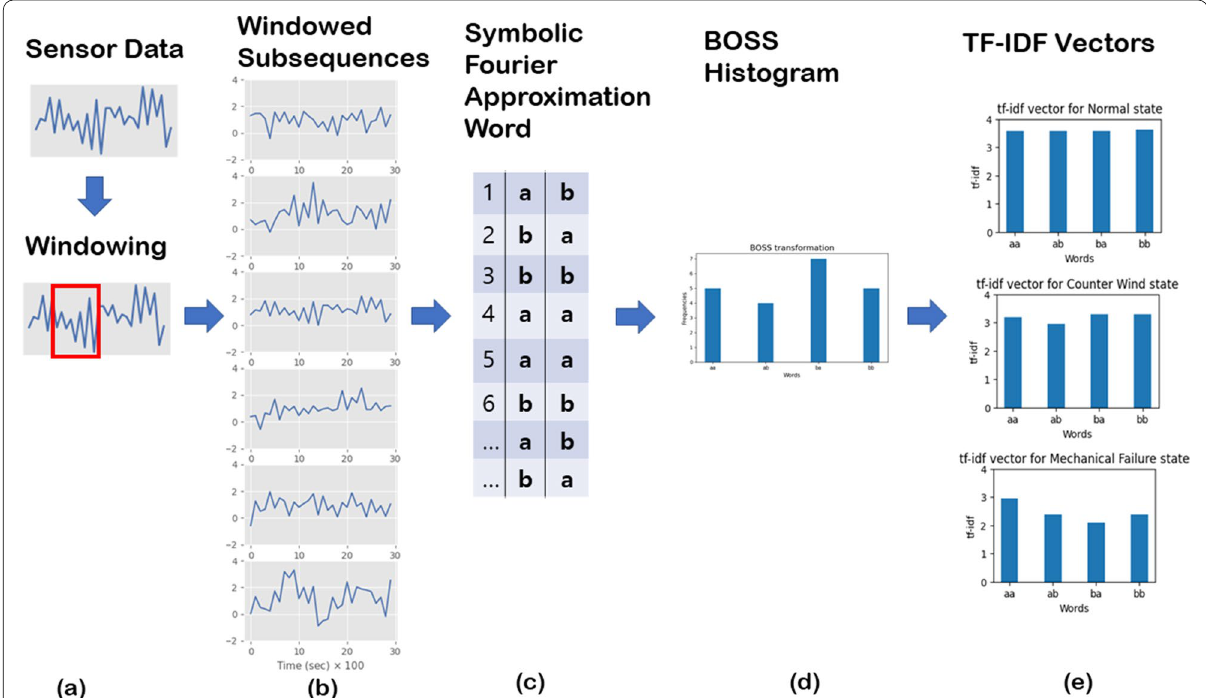
Fig. 6 BOSS model and BOSS VS: a Samples are being scanned with a sliding window, b multiple windowed subsequences are generated, c all of the subsequences are transformed into SFA words, d SFA words are summarized in the form of BOSS histogram (BOSS model), and e the BOSS histogram is vectorized through Term Frequency Inverse Document Frequency (TF‑IDF) model, which finally results in TF‑IDF vectors for training